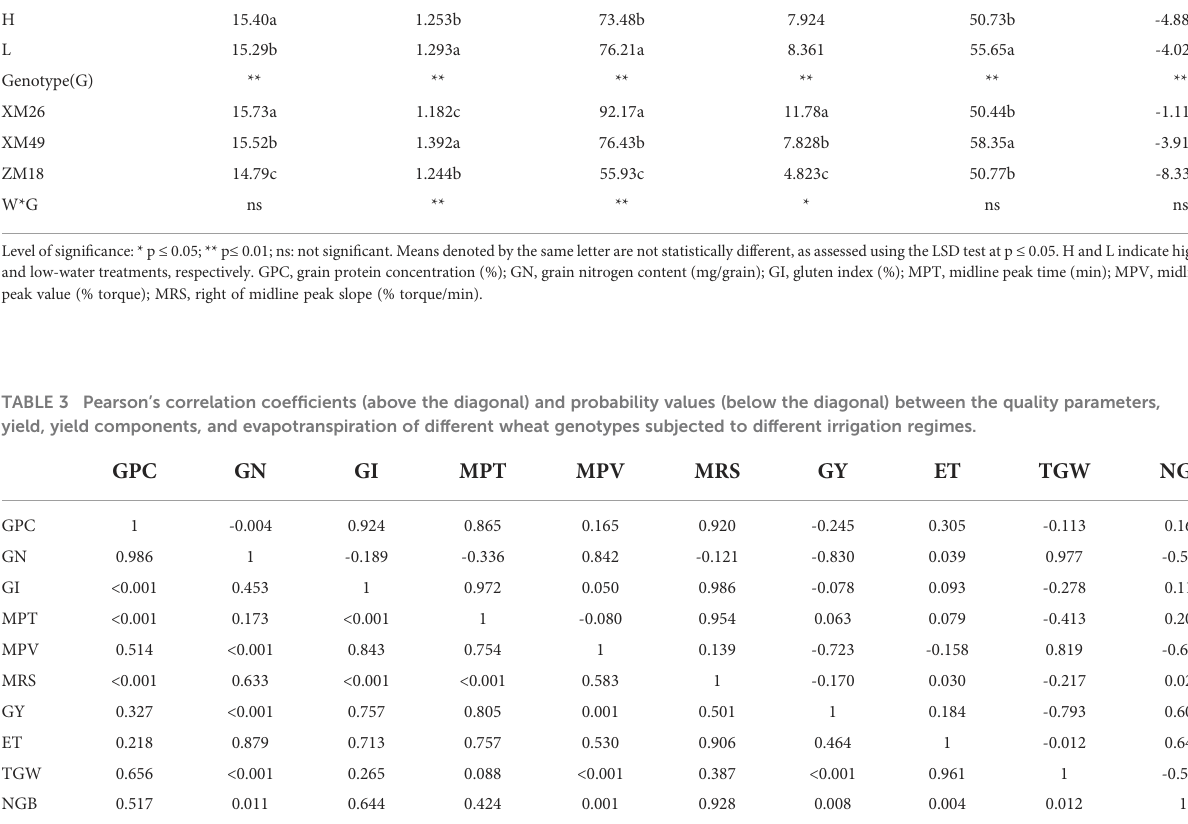
Figure 3. The data indicated that yield correlated negatively with TGW (r = – 0.793, p< 0.01), although positively correlated with the number of grains per barrel (NGB; r = 0.603, p< 0.01). NGB was signi fi cantly positively correlated with ET (r = 0.643, p< 0.01). In addition, a signi fi cant negative correlation (r = – 0.58, p< 0.05) between TGW and NGB was also recorded.